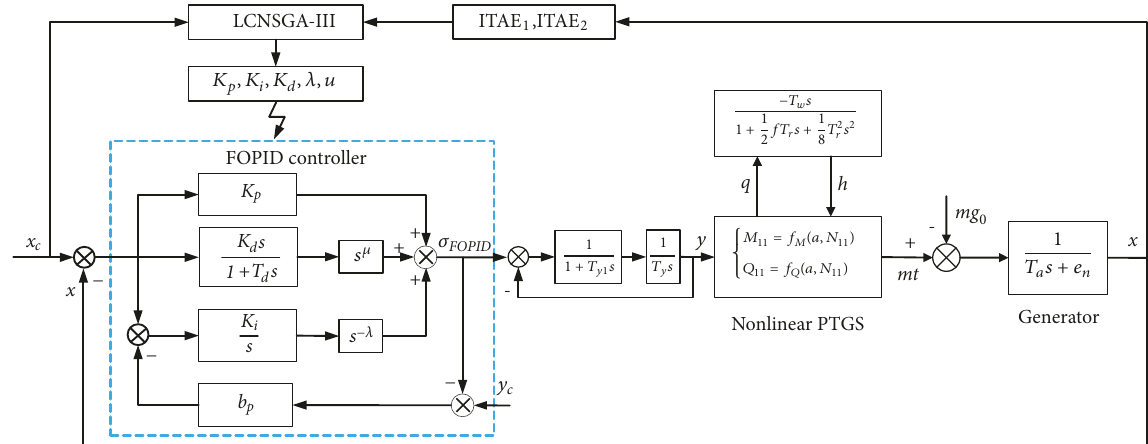
Figure 4: Schematic diagram of the MO-FOPID problem optimized by LCNSGA-III under multiworking conditions.